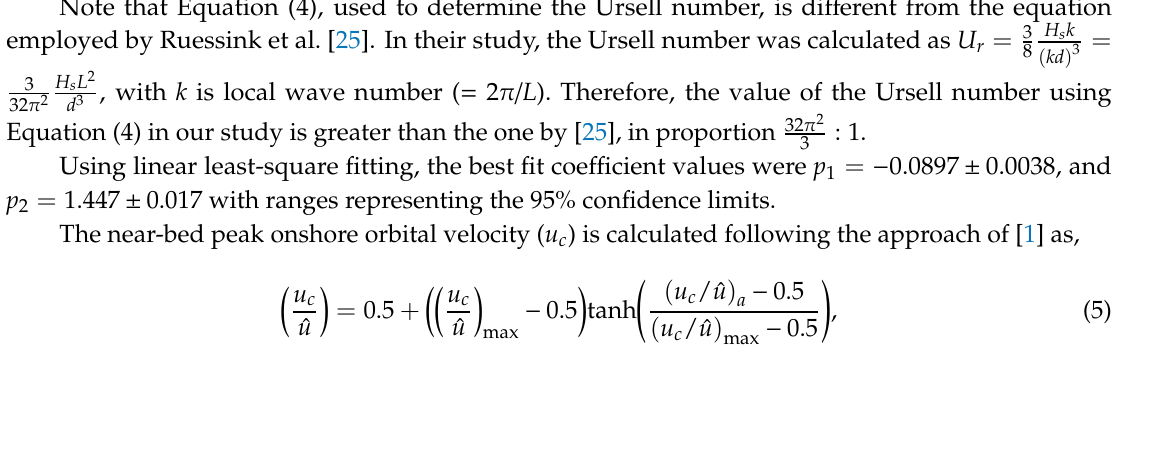
with ranges representing the 95% confidence limits.